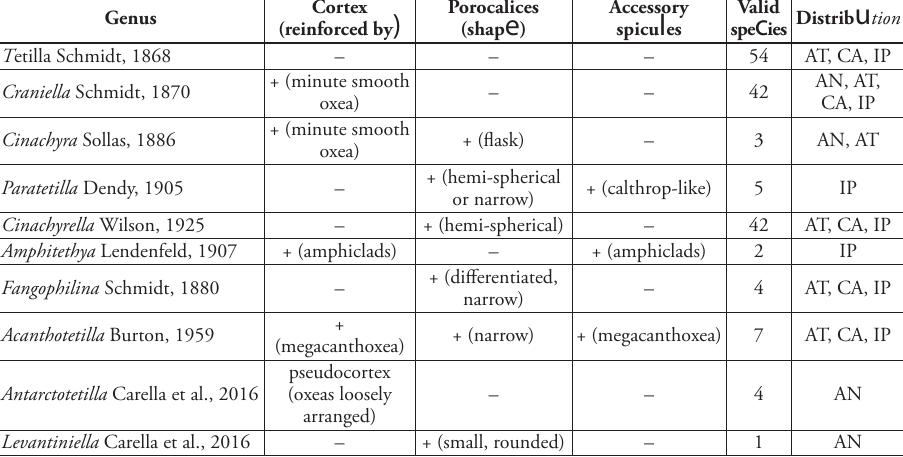
Table 1. Valid genera of Tetillidae Sollas, 1888 and principal characteristics used to distinguish them. (+) present, (-) absent. (AN) Antarctic, (AT) Atlantic, (CA) Caribbean, (IP) Indo-Pacific. Modified from Rützler (1987), van Soest and Rützler (2002), Carella et al. (2016). Number of valid species consulted at the World Porifera Database (van Soest et al. 2018; accessed 04 Jun 2018). Genus